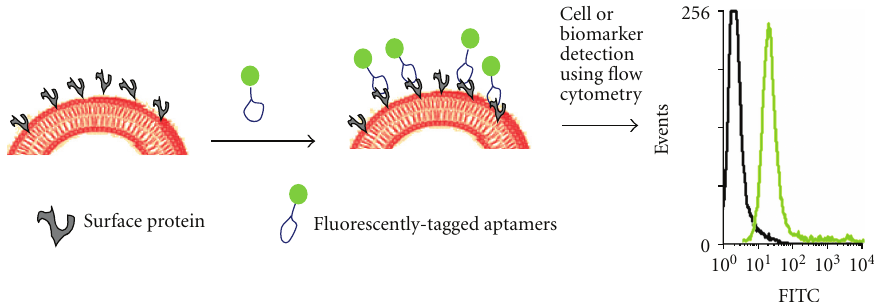
F 1: �etection of surface proteins or biomarker in cancer cells using �uorescently tagged aptamers.